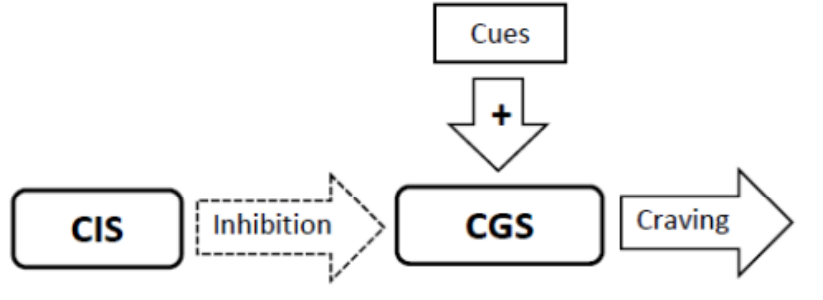
indicates that the CIS system is